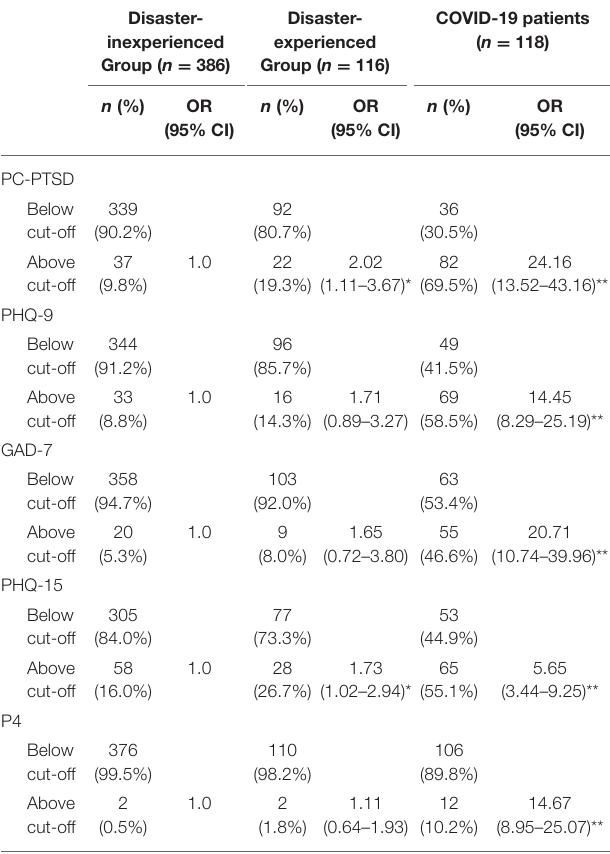
TABLE 3 | Adjusted odds ratio of severe mental health problems among COVID-19 patients and comparison groups. Disaster-